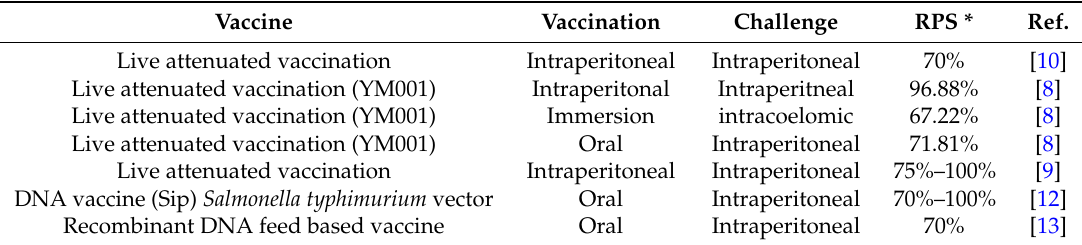
Table 1. Live attenuated and DNA vaccines showing delivery systems and modalities of vaccination. Vaccine